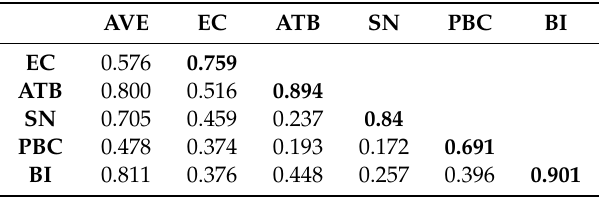
Table 5. Discriminant validity for the measurement